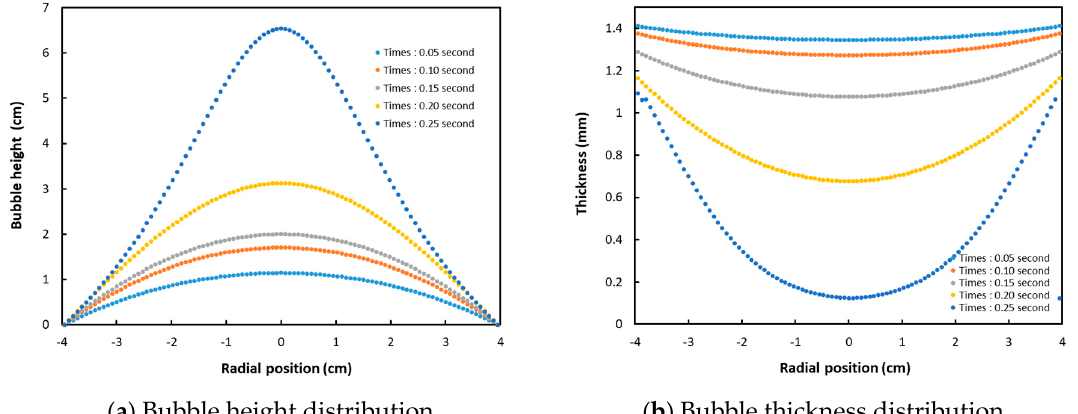
Figure 6. Geometrical PMSQ–HDPE membrane according to Christensen’s model at 0.05, 0.10, 0.15, 0.20, and 0.25 s : ( a ) Bubble height, ( b ) Bubble thickness, ( c ) Stretch ration λ 1 and ( d ) Stretch ration λ 2